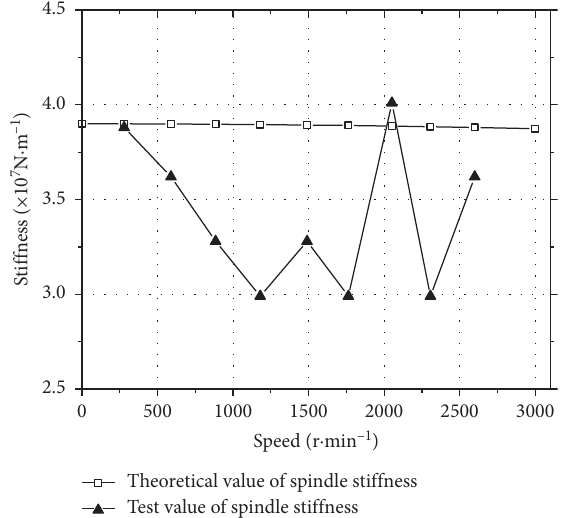
Figure 11: Test value and theoretical value of spindle stiffness via the